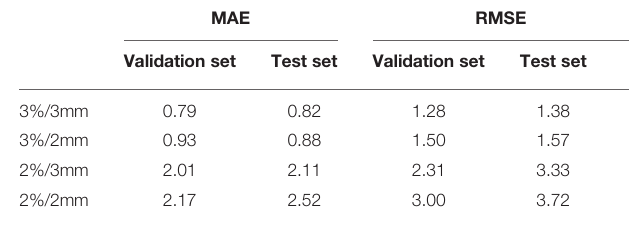
TABLE 2 | MAE and RMSE for different gamma criteria.